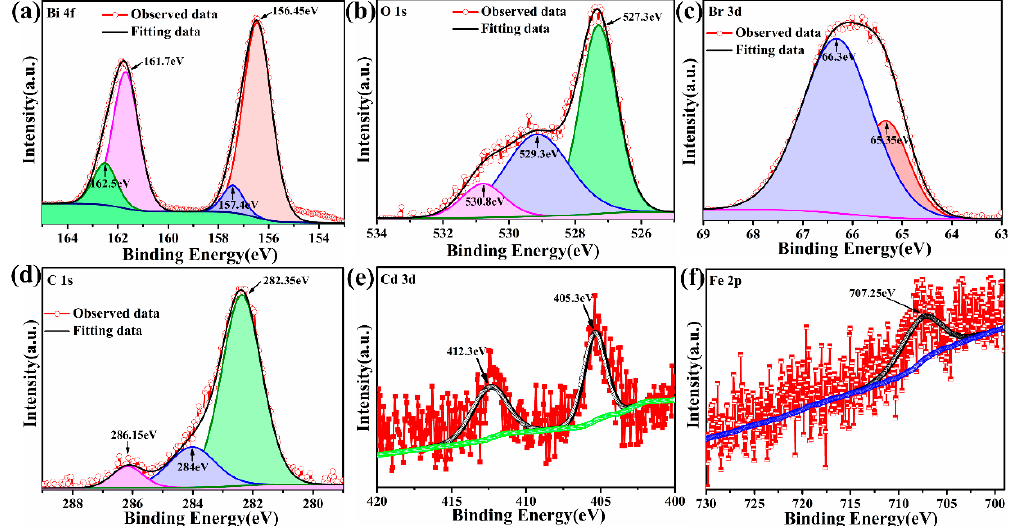
Figure 4. High-resolution XPS spectra of Fe/Cd co-doped BiOBr, Bi 4f spectrum ( a ), O1s spectrum ( b ), Br 3d spectrum ( c ), C 1s spectrum ( d ), Cd 3d spectrum ( e ) and Fe 2p spectrum ( f ).